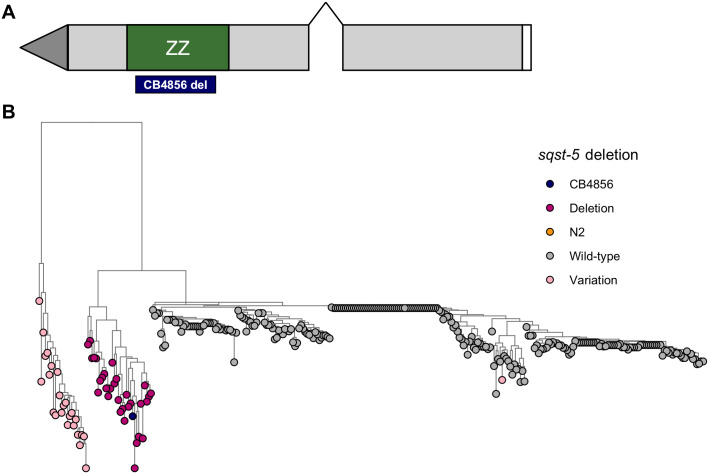
Natural genetic variation in sqst-5.(A) Gene model of sqst-5. Grey rectangles represent exons, and connecting black lines represent introns. The ZZ-type domain is indicated by a green rectangle, and the location of the natural 111 bp deletion in the CB4856 strain is indicated below with a blue rectangle. (B) Neighbor-joining tree indicating genetic relatedness between wild isolates at the sqst-5 locus. Branch lengths indicate the rate, the tree is midpoint rooted. Tips are colored by the variation haplotype at sqst-5: (Wild-type: grey, N2: orange, CB4856: navy, Deletion: magenta, Other putative structural variation: light pink).